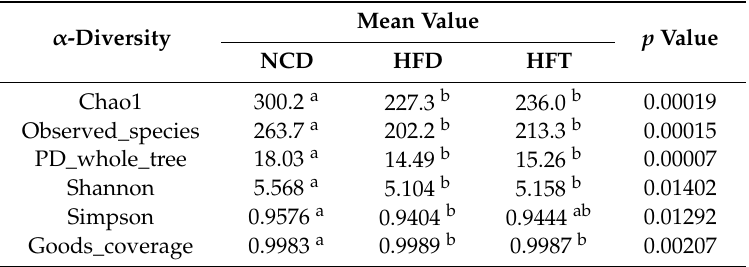
Table 3. The α -diversity indices of gut microbiota in C57BL / 6